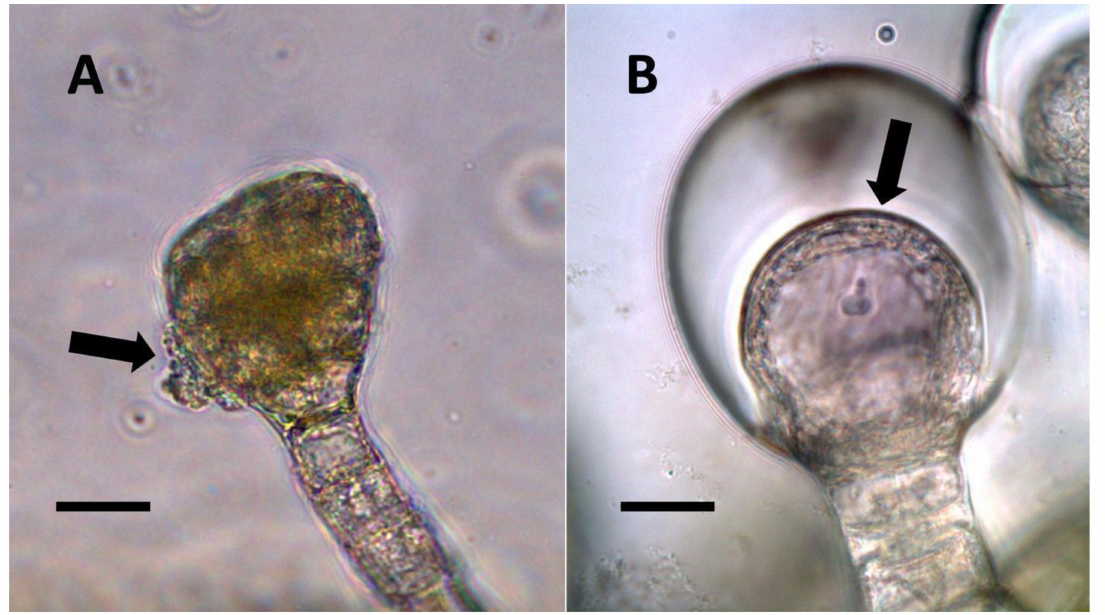
Figure 9. Glandular trichomes of Lonicera japonica and Citronella mucronata . ( A ) Developing glan- dular trichome of Lonicera japonica stained with iron sulfate to show nitric oxide (brown color) in trichome and bacteria emerging from trichome (arrow) (Bar = 10 µ m). ( B ) Glandular trichome of Citronella mucronata stained with iron sulfate to show nitric oxide (brown color) (arrow) around bacteria in hair (Bar = 10 µ m).